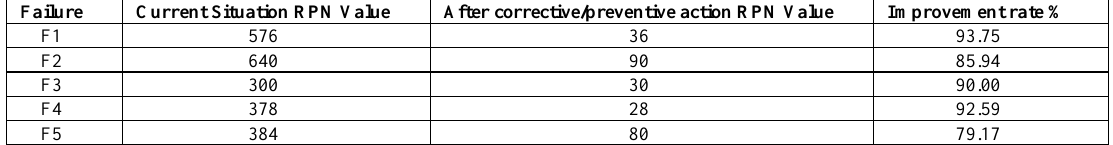
Table 2: Improvement rate of risks after corrective / preventive